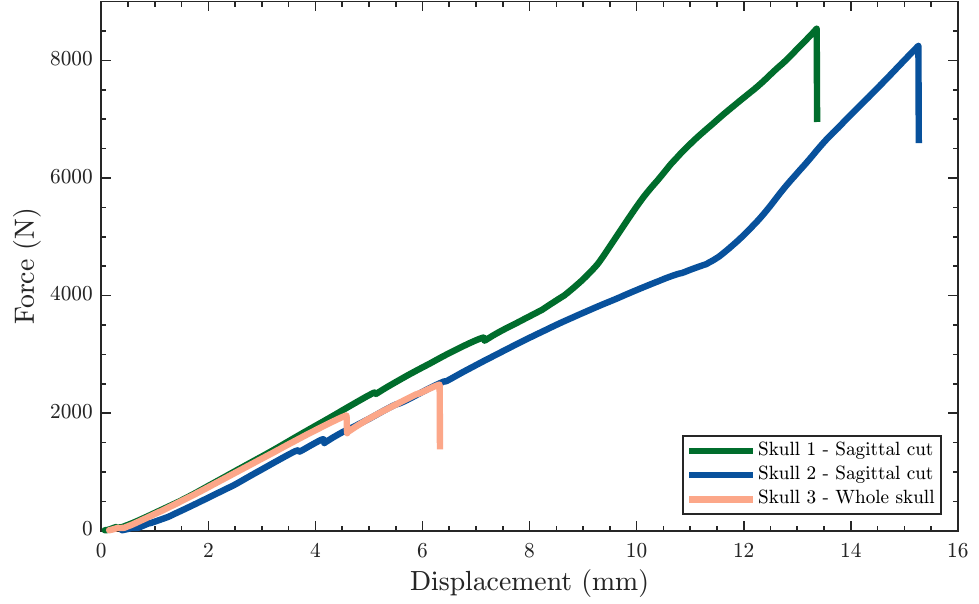
Figure 6. Force-displacement curves showing the response of skull surrogates to lateral compres- sive